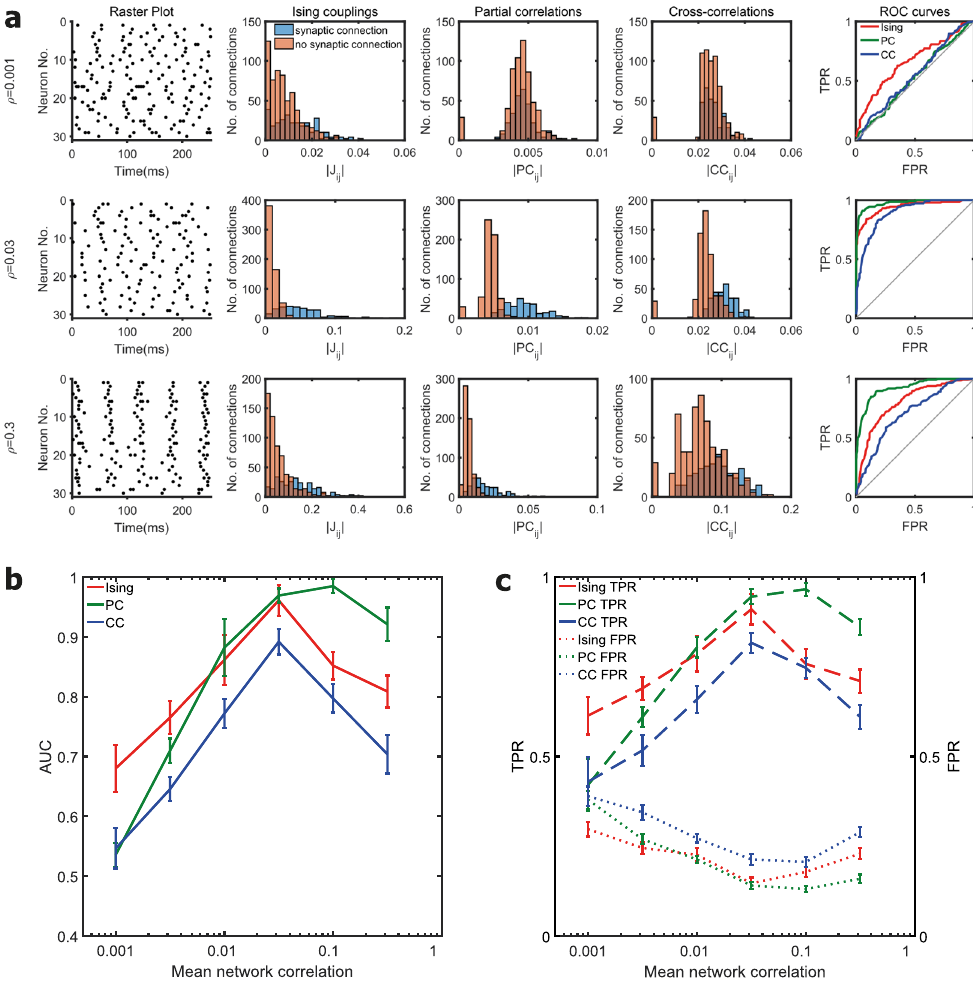
Figure 1. Effect of mean network correlation. (a) The first column in each row shows the raster plot of the spiking activity from a simulated neuronal network for a firing rate of 20 Hz and different network correlation levels. Histogram of the Ising couplings, partial correlations and cross-correlations for the pairs of neurons that are synaptically connected and not connected are shown respectively in the second, third and fourth columns. The corresponding ROC curves of the three functional connectivity metrics are shown in the last column. The first, second and third rows correspond to mean network correlation levels ( ρ ) of 0.001, 0.03 and 0.3 respectively. (b) Plot of the AUC values for different mean network correlation levels in scale-free networks of 30 neurons for a fixed firing rate of 20 Hz. Mean value was calculated from ten simulated networks. For weaker correlation levels (0.001 and 0.003), AUC value of Ising couplings was significantly higher than partial and cross-correlations. For stronger correlation levels (0.1 and 0.3), partial correlations had a significantly higher AUC value compared to Ising couplings and cross-correlations ( p < 0.01, two-sample t-tests). (c) True positive rate (TPR) and false positive rate (FPR) for the reconstruction of the structural connections by the three functional connectivity metrics thresholded at a sparsity threshold value of